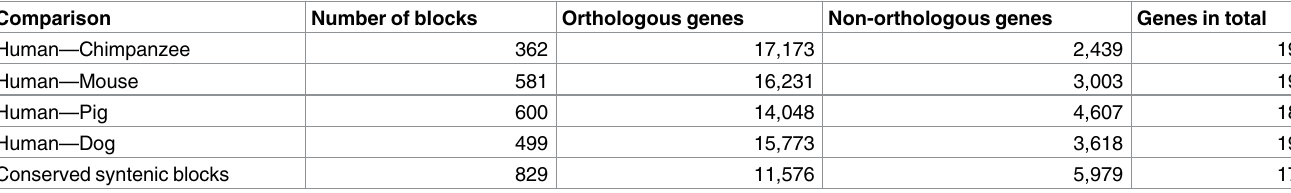
Table 1. Number of orthology-based syntenic blocks and their gene